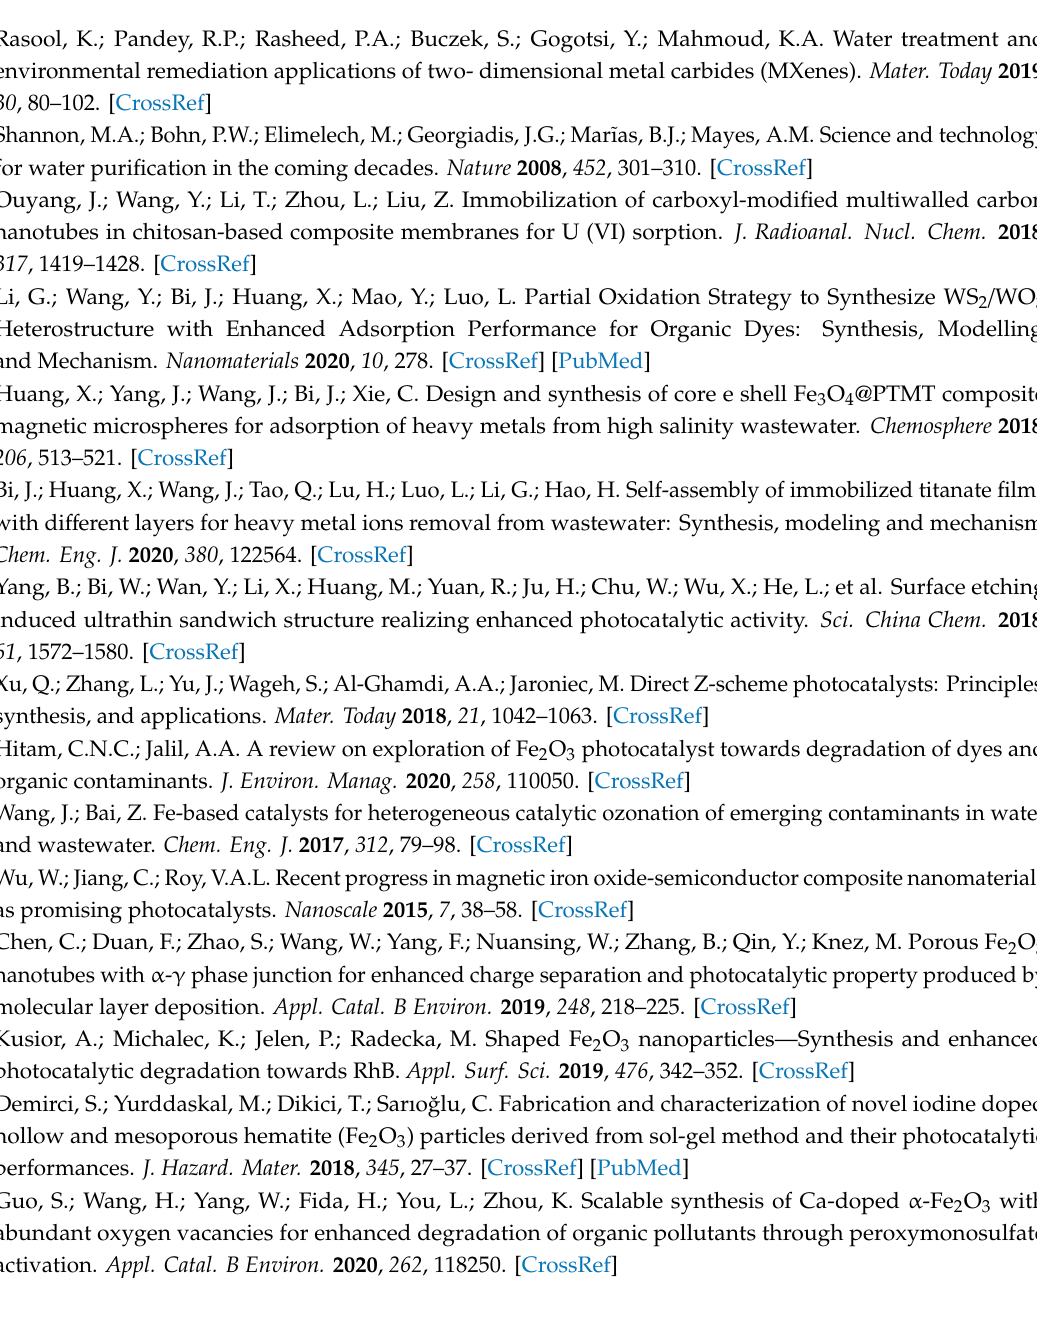
Figure S1: N 2 adsorption-desorption isotherms, Figure S2: Decay curve fitting procedures for the synthesized samples; Figure S3: Magnetization curve of Fe 2 O 3